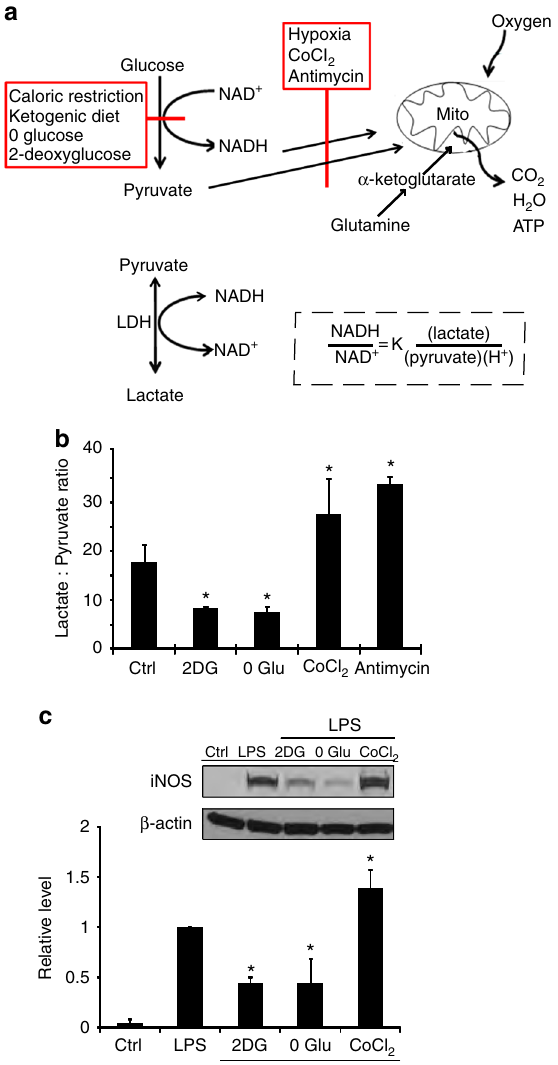
Fig. 2 Relationships between glucose metabolism and cytosolic NADH: NAD + ratio. a Factors that reduce glucose fl ux through glycolysis, such as reduced glucose availability or glycolytic inhibitors, reduce NADH levels and thereby reduce NADH:NAD + ratio, whereas factors that inhibit oxidative metabolism, such as hypoxia and mitochondrial inhibitors, have the opposite effect. Glutamine provides ketone bodies ( α -ketoglutarate) to fuel mitochondrial ATP production in the absence of glycolysis. Lactate dehydrogenase (LDH) maintains the lactate:pyruvate ratio in equilibrium with the cytosolic NADH:NAD + ratio. b The lactate:pyruvate ratio provides an index of the cytosolic NADH:NAD + ratio in cells treated with glycolytic and mitochondrial inhibitors. 2DG, 1 mM 2-deoxyglucose; 0 Glu, glucose- free medium; CoCl 2 , 200 µ m cobalt chloride; antimycin, 1 µ m antimycin A. n = 4; * p < 0.05 v. control. c LPS-induced iNOS expression was suppressed in RAW267.4 cells treated with 1 mM 2DG or glucose-free medium, and increased in cells treated with the mitochondrial inhibitor cobalt chloride (CoCl 2, 200 µ m). n = 4; * p < 0.05 v. control. Error bars show s.e.m. Full length immunoblots are shown in Supplementary Fig.